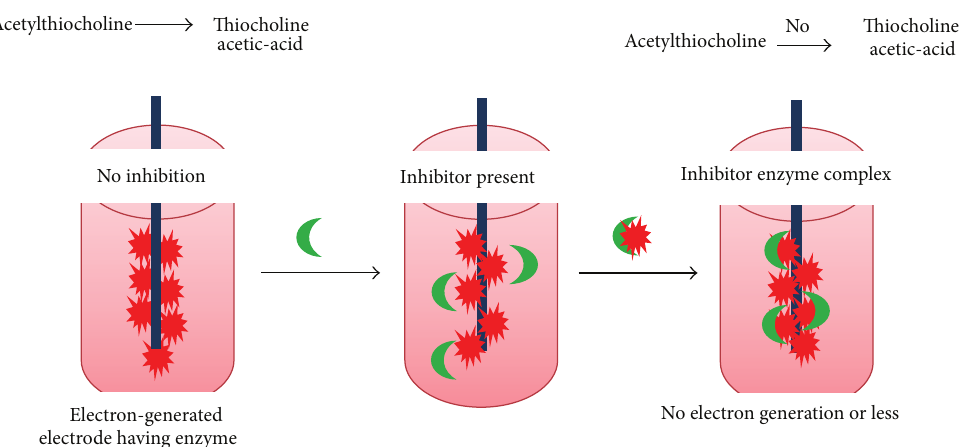
Figure 2: Principle of AChE inhibition-based OP biosensor.